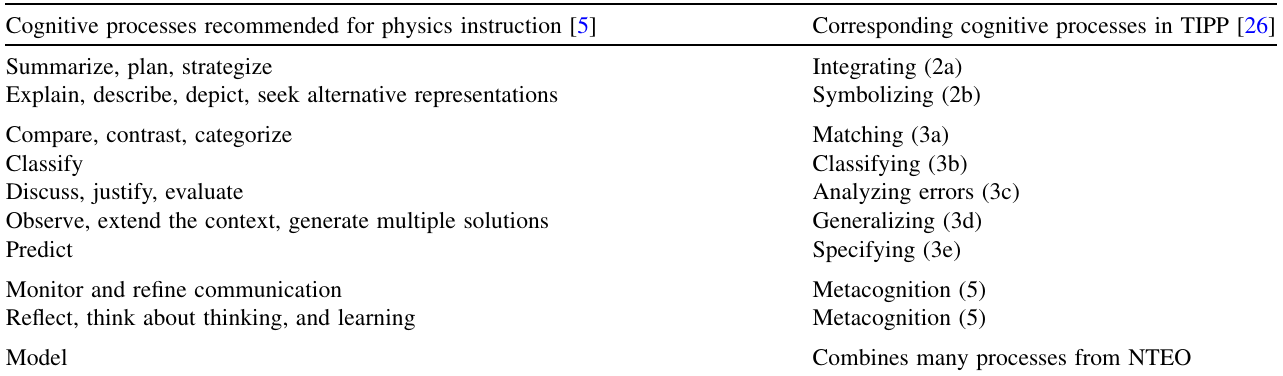
TABLE III. How we map the cognitive processes suggested for classroom practice [5] with the ones from NTEO (used in TIPP). Cognitive processes recommended for physics instruction [5] Summarize, plan,